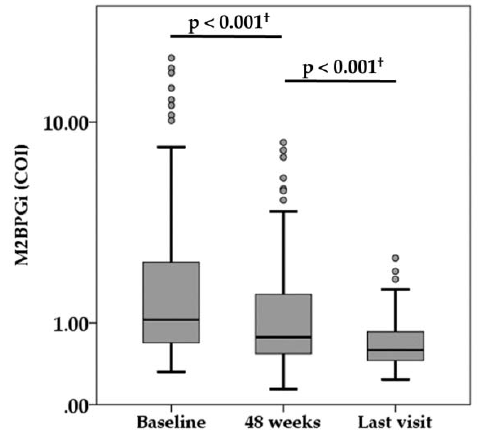
Table 1. Virologic and biochemical data during NA treatment. Baseline 48 Weeks Last Visit p -value